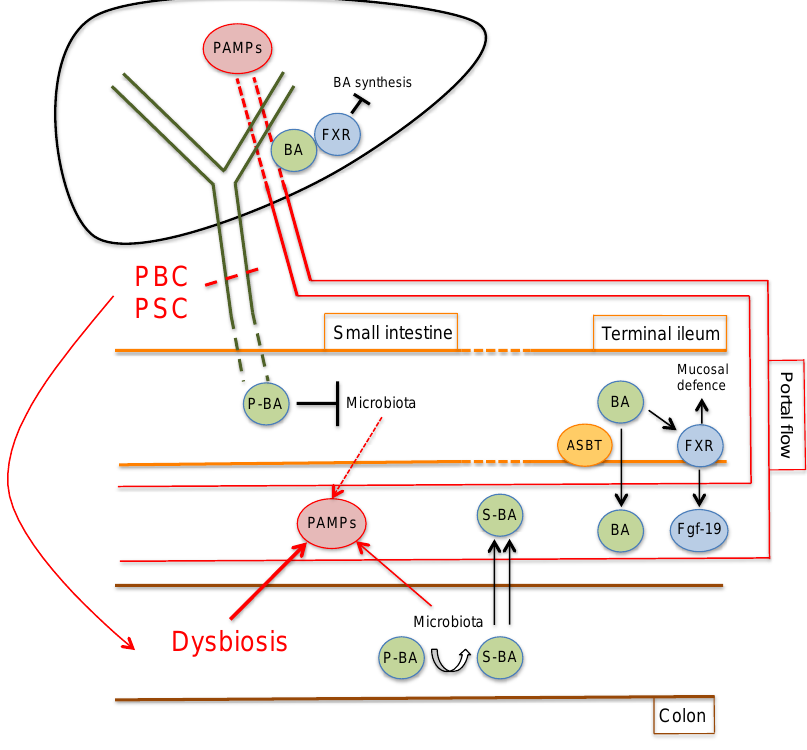
Figure 2. Gut–liver axis during cholangiopathies. In normal conditions, primary bile acids (P-BA) reach the small intestine where they directly influence the microbiota composition, mainly by blocking bacterial overgrowth. BA are actively reabsorbed in the terminal ileum via the apical sodium-dependent bile acid transporter (ASBT) and activate farnesoid X receptor (FXR), which, in turn, causes Fgf-19 secretion and direct effects on mucosal defense. In the colon, bacterial metabolization produces a wide variety of secondary bile acids (S-BA), which also enter the portal circulation. Cholangiopathies, which alter the normal bile flow or composition, may interfere with all these processes, ultimately causing dysbiosis and an increased or qualitatively altered PAMPs delivery to the liver via the portal circulation.